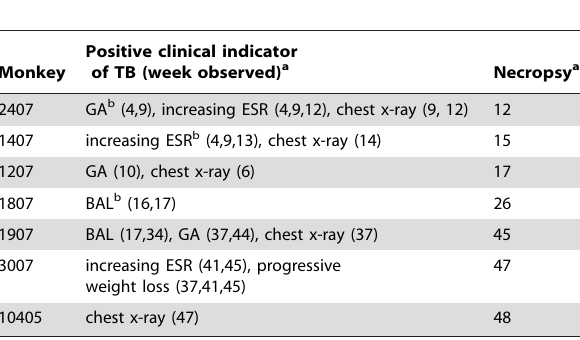
Table 1. Clinical evidence for reactivated TB in co-infected